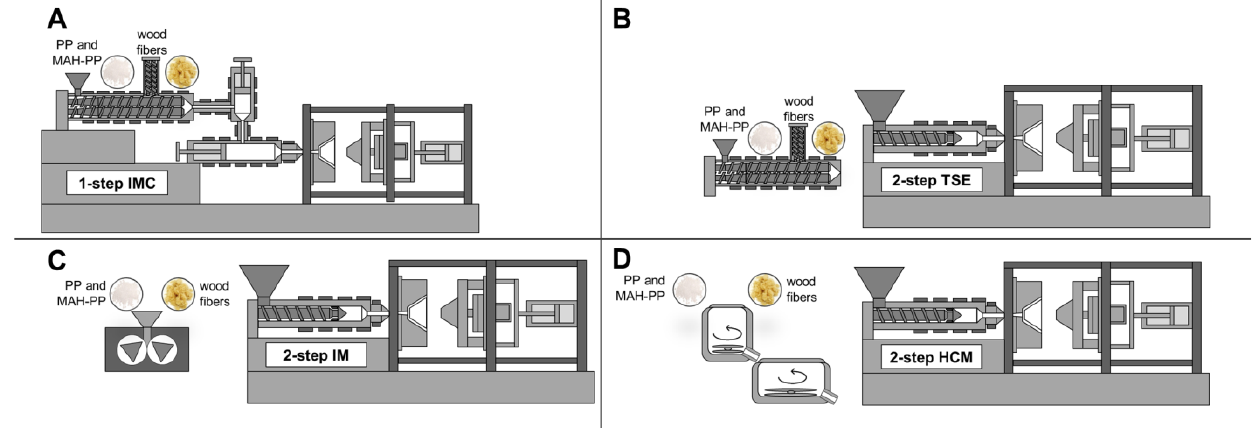
Figure 2. Schematic illustration of all melting processes investigated. ( A ) Injection-molding com- pounder, ( B ) twin-screw-extruder and injection molding, ( C ) internal mixer and injection molding, ( D ) heating cooling mixer and injection molding.